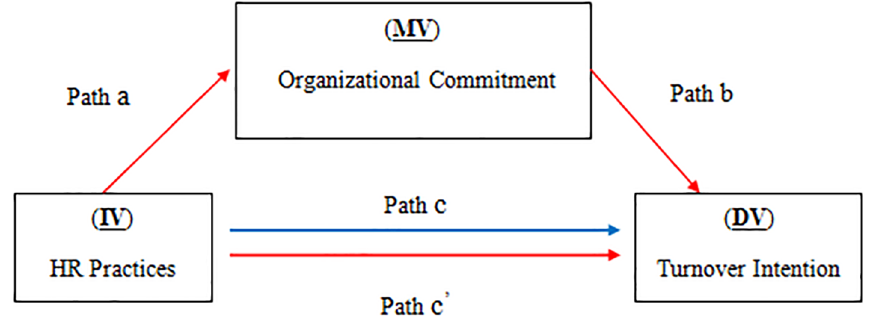
Figure 2. The effect of HR practices (IV) on intention to turnover (DV) with the mediating role of OC